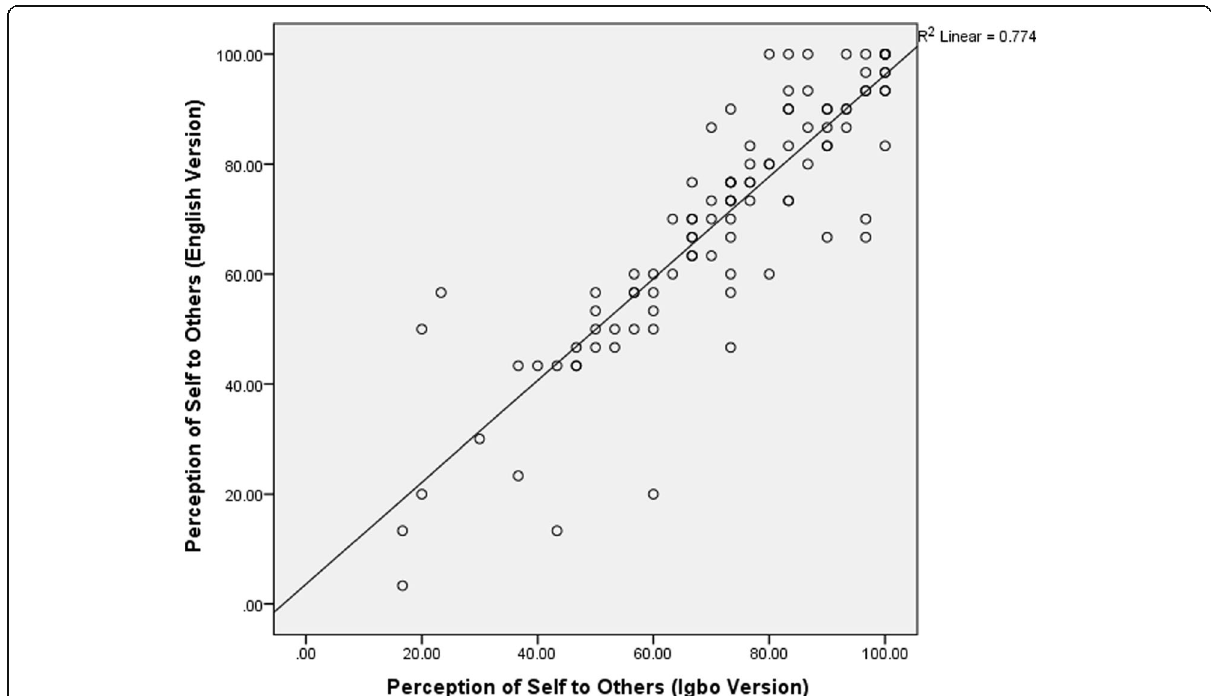
Fig. 3 Scatter Diagram for perception of self to others subscale scores on the E-RNLI and the I-RNLI. KEY : I-RNLI = Igbo version of Reintegration to Normal Living Index. E-RNLI = English version of Reintegration to Normal Living Index